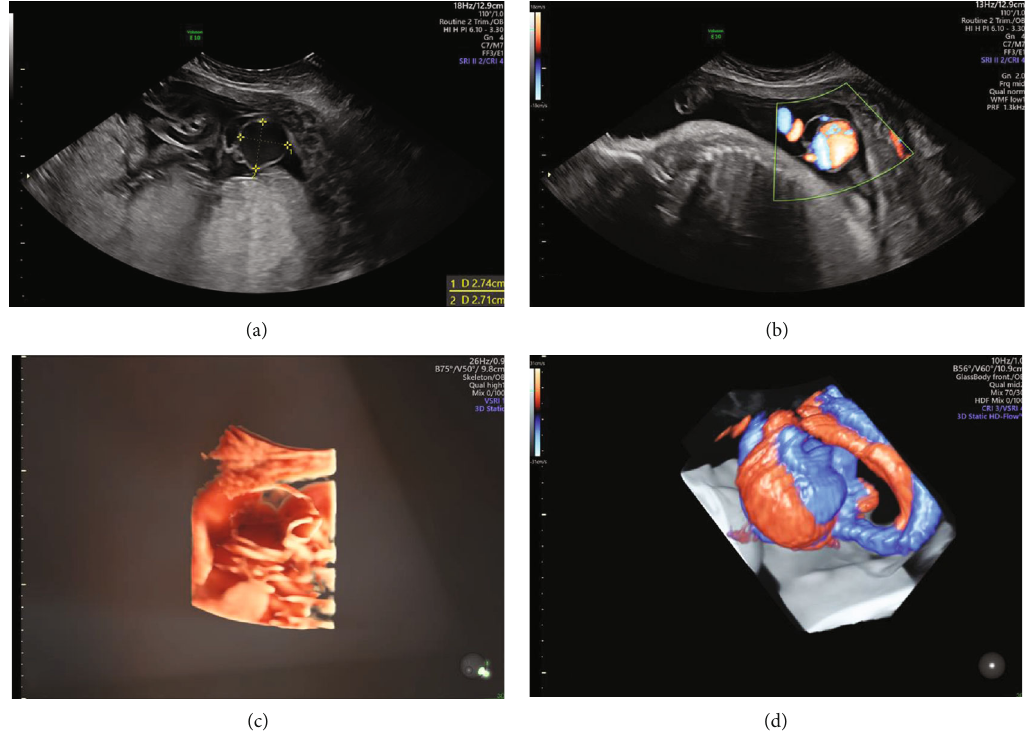
Figure 2: (a) Top left — 2.7cm umbilical vein aneurysm free- fl oating cord. (b) Top right — color doppler demonstrating bidirectional fl ow within umbilical vein aneurysm. (c) Bottom left — high de fi nition live 3D rendering of umbilical vein aneurysm. (d) Bottom right — color 3D rendering of umbilical vein (1 : 80) on fi rst trimester screen. Prior to transfer to our hos- pital, she received two doses of betamethasone and a magne- sium sulfate infusion for fetal neuroprotection.